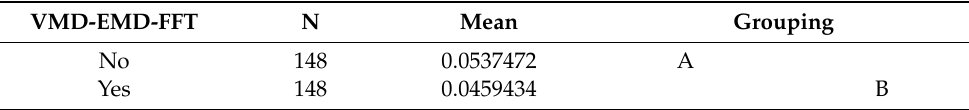
Table 11. Tukey’s pairwise comparison between including and excluding VMD-EMD-FFT data decomposition.